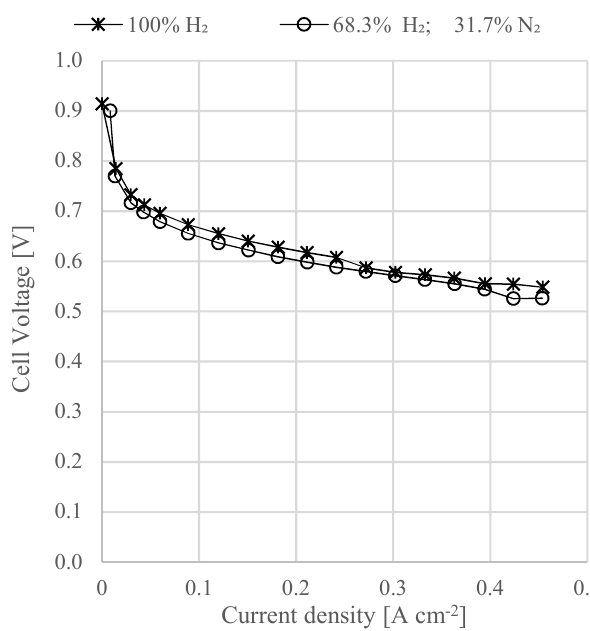
Figure 4. Experimental polarization curves of a HT-PEMFC stack fueled by hydrogen and a mixture of hydrogen and nitrogen.